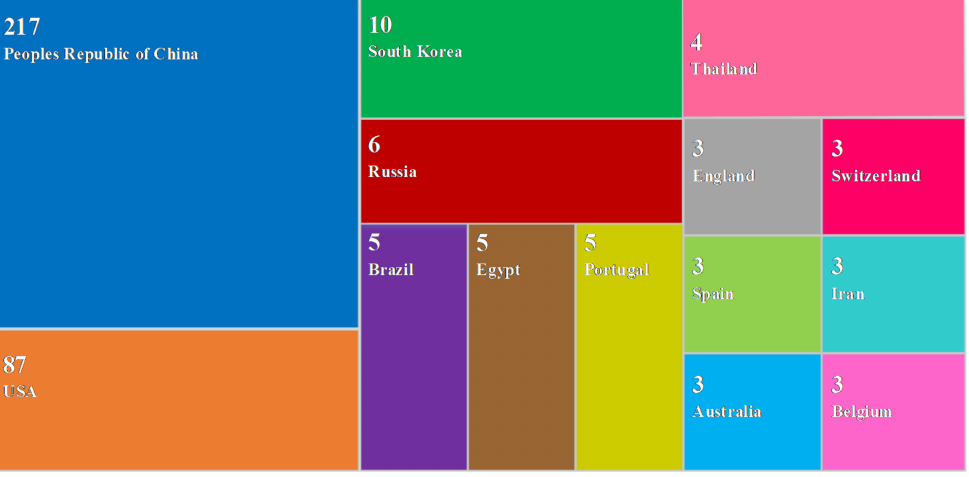
Figure 5. Top 10 countries in search of related literature by key